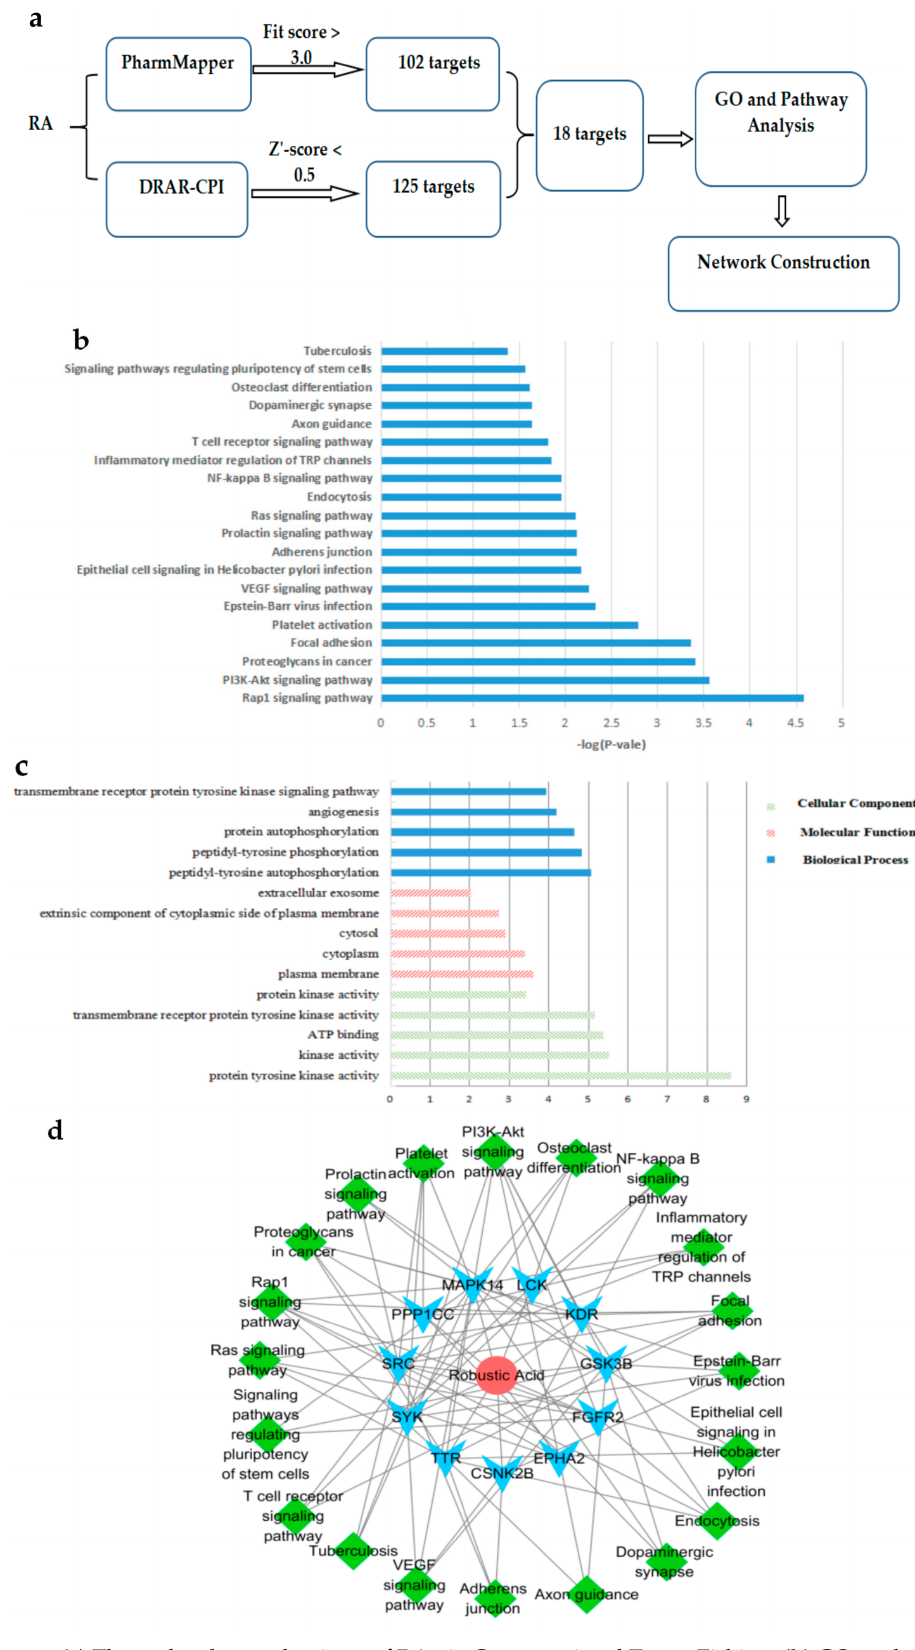
Figure 3. ( a ) The molecular mechanisms of RA via Computational Target Fishing; ( b ) GO analysis of potential targets; ( c ) KEGG pathway analysis of potential targets; ( d ) RA-target-pathway